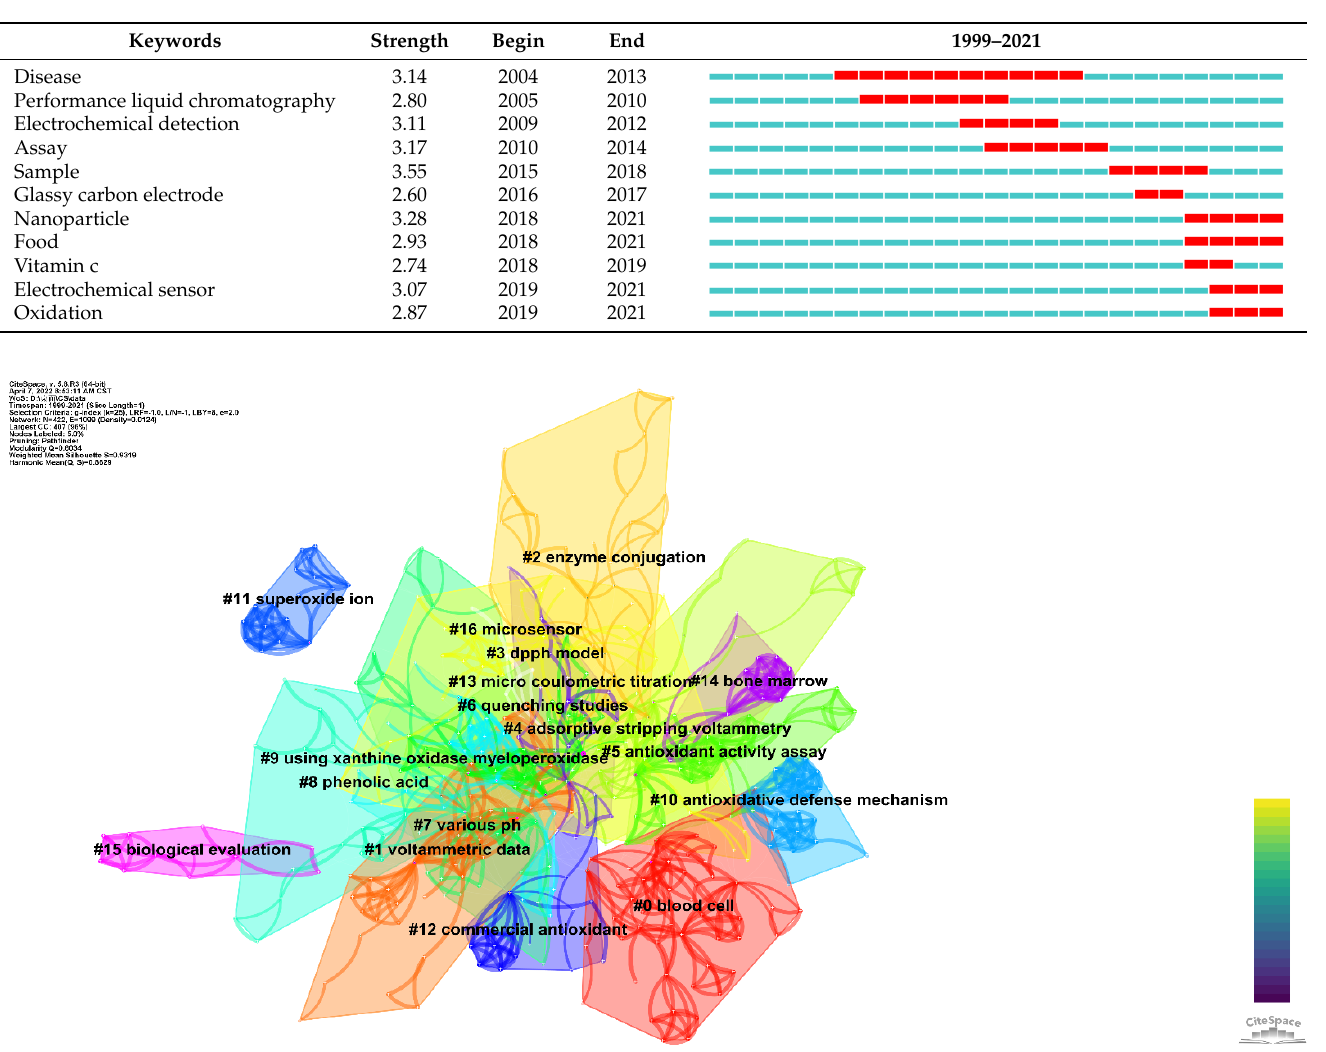
Figure 8. Grouping of keywords for the evaluation of antioxidants using electrochemical sensors. #0 (blood cell) The reports in this cluster mainly describe two types of studies. The